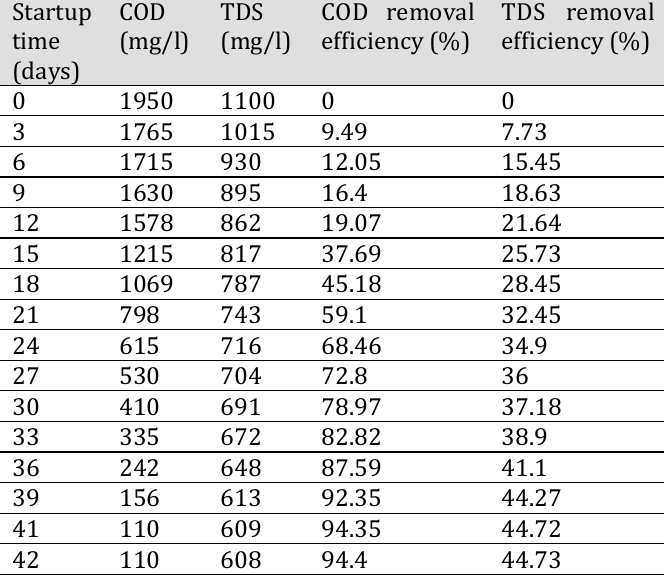
Table 3. MBBR system startup phase monitoring for chemical oxygen demand (COD) and total dissolved solids (TDS) concentration changes and their removal efficiency